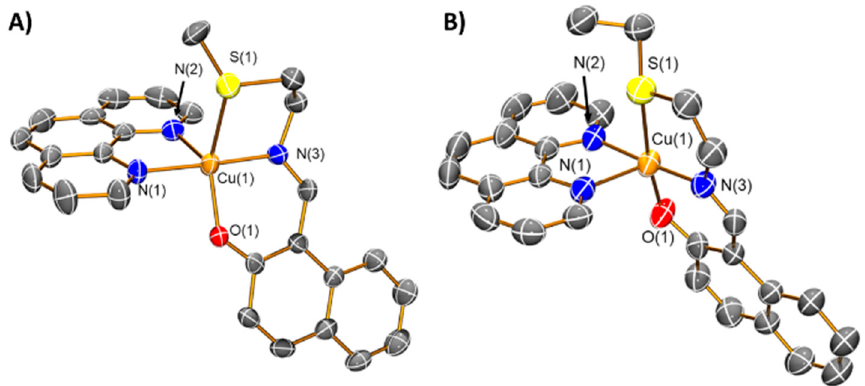
Figure 1. X ‐ ray structures of the copper(II) complexes 2 ( A ) and 3 ( B ) comprising of L 2 or L 3 and 1,10 ‐ phenanthroline. Ellipsoids are shown at 50% probability. C in grey, N in dark blue, S in yellow, O in red, and Cu in orange. H atoms, disorder components, and the hexafluorophosphate counter anion have been omitted for clarity.